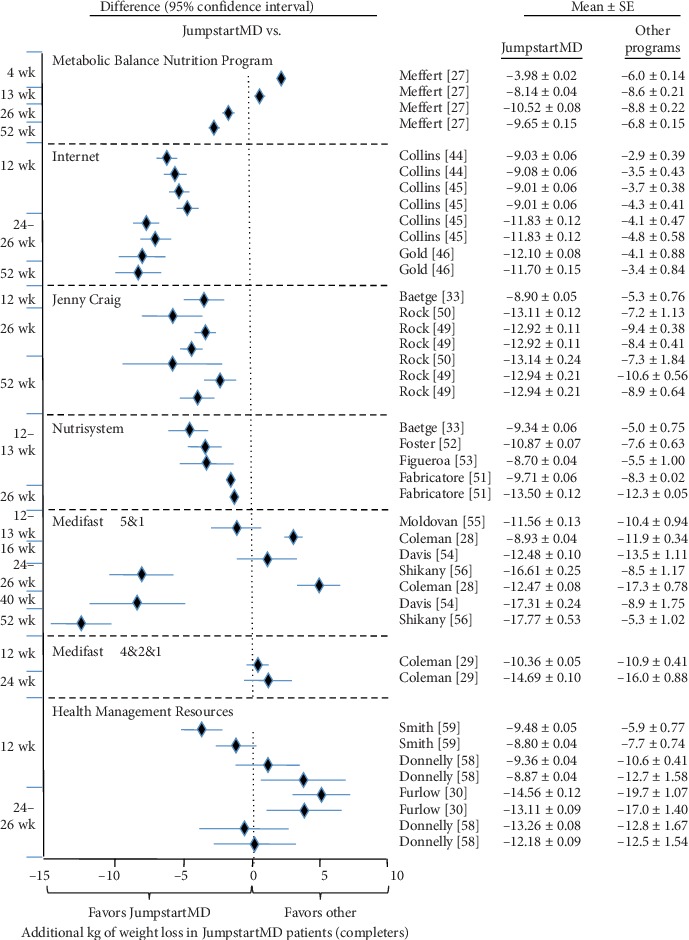
Mean weight loss difference between JumpstartMD and other commercial programs in completers as measured by kg weight loss (continued). Negative differences designate greater JumpstartMD weight loss. See legend to Figure 5 for further explanation.